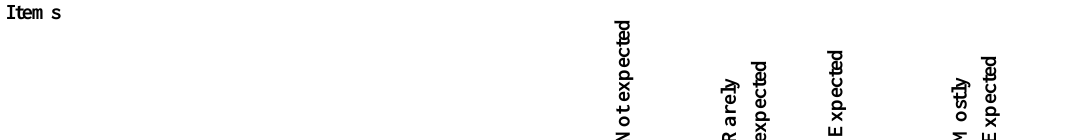
Table 2: Managers’ expectations on graduate employability skills at